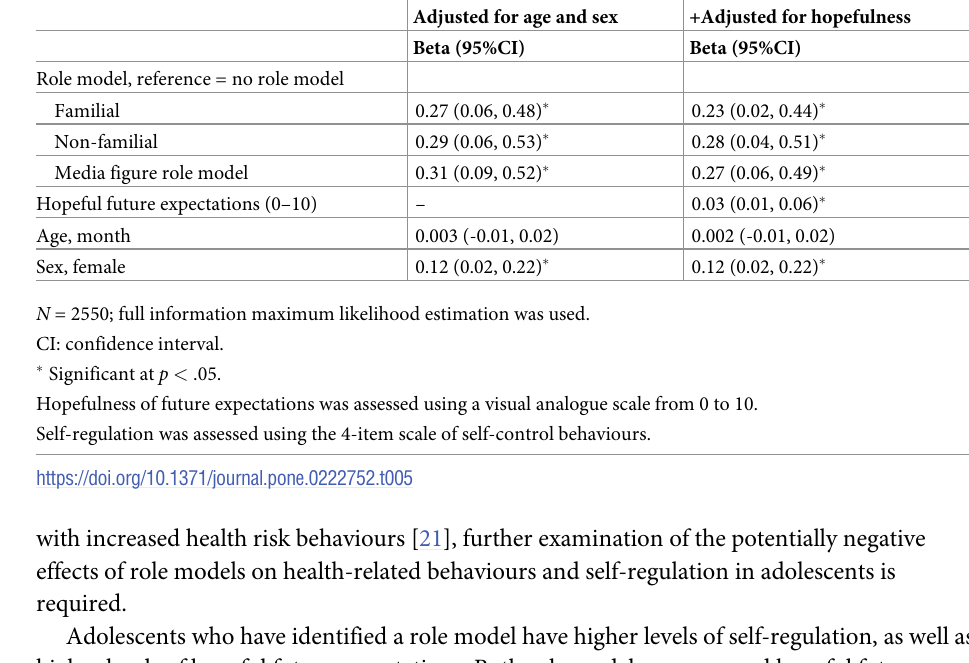
Table 5. Estimated coefficients (Beta) predicting level of